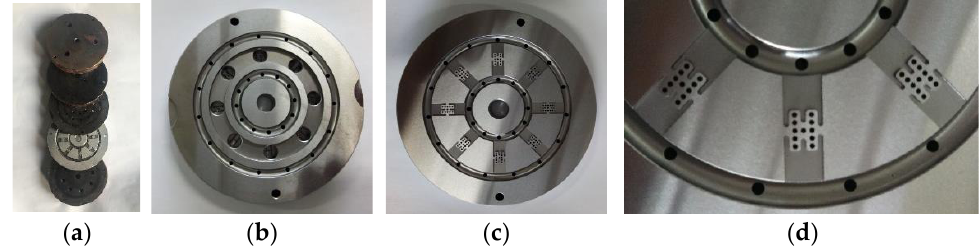
( c ) Figure 11. Cross-sections of “H - shaped” fibers with different flow ratios. ( a ) The flow ratio is 1:2:1; ( b ) the flow ratio is 1:1:1; ( c ) the flow ratio is 2:1:2. From Figure 11, it is observed that the cross-section of the three-component compo- site fiber has an “H - shaped” pattern form ed by red PP and black PP wrapped with trans- parent PA6, and the cross- sectional pattern is clearly visible. The “H - shaped” pattern of the three-component composite fiber cross-section is found to vary with the flow ratio of the three components. As the flow of red PP and black PP becomes larger, the PA6 domain is gradually wrapped. When red PP: PA6: black PP = 2:1:2, the PA6 domain is completely wrapped. In order to observe the fiber cross-section morphology more clearly, an electron mi- croscope (model: JSM-5600LV, manufacturer: JEOL Ltd. Akishima-shi, Japan) was used, and its magnification ranged from 18 to 300,000 times. Several fibers were randomly se- lected from each group of fibers that were prepared in the experiment as samples. Before making the fiber section for SEM observation, in order to prevent the fiber section from being deformed due to cutting, the fibers were first frozen with liquid nitrogen, initially. Then, they were cut with a knife tool to obtain the section. Finally, according to the oper- ating procedures, the fiber samples were placed under a scanning electron microscope for observation. The fiber cross-section SEM images of the optimized “fishbone” pattern three- component composite fiber and “H - shaped” pattern three -component composite fi- ber samples are shown in Figure 12.